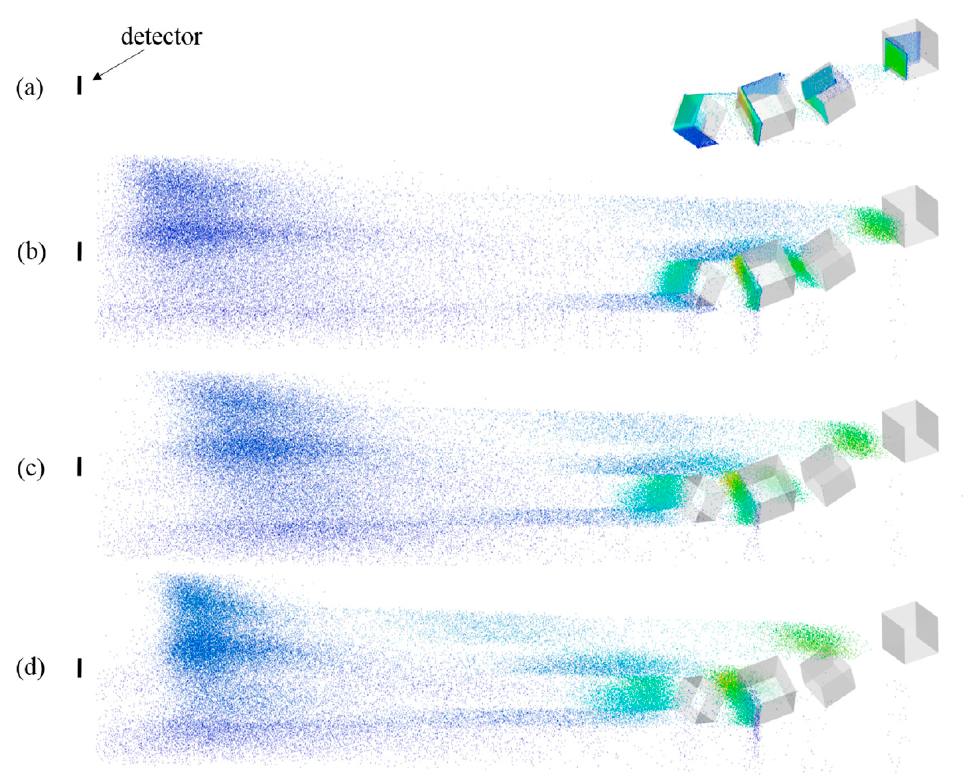
Figure 2. Point cloud describing the reconstructed ToF image (colors) compared to the ground truth (grey) for different fog scenarios, ordered from top to bottom with increasing scattering cross-section. ( a ) No fog. The difference between reconstructed image and ground truth arises from lens aberration effects. ( b ) Particle radius r = 1.5 µm, ρ = 497 particles/cm 3 . ( c ) r = 10 µm, ρ = 40 particles/cm 3 . ( d ) r = 5 µm, ρ = 200 particles/cm 3 .